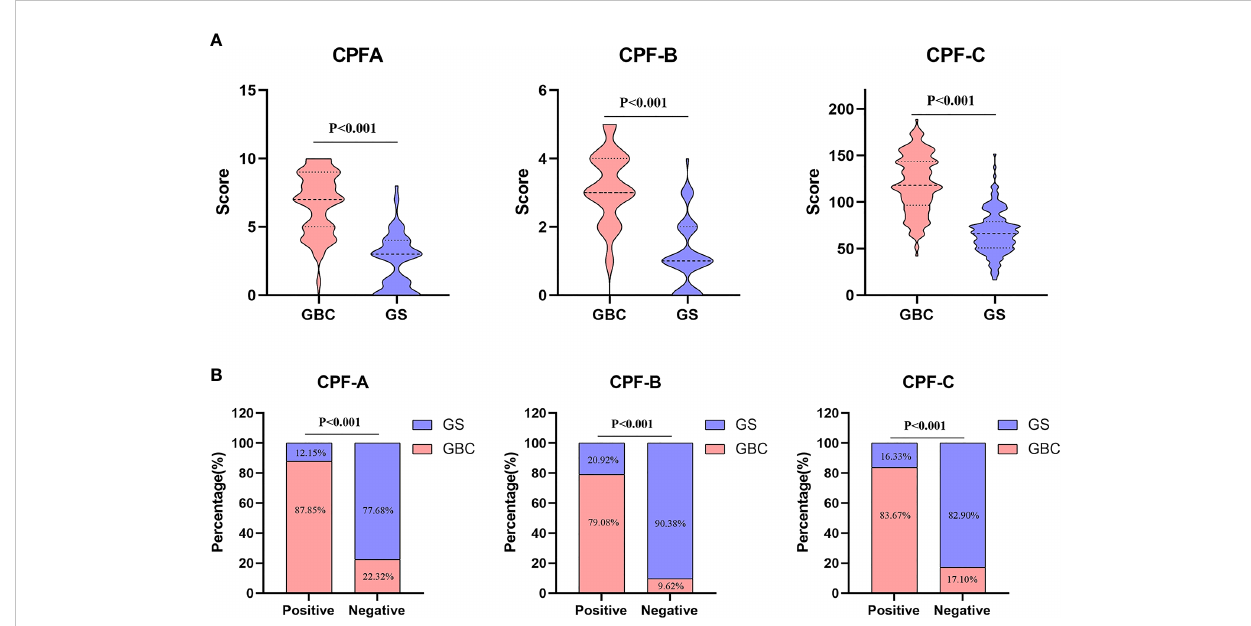
FIGURE 3 Data of combined predictive factor (CPF)-A, CPF-B, and CPF-C. (A) Comparison of CPF-A, CPF-B, and CPF-C scores between GBC and GS in the internal test samples. (B) Diagnosis rate of CPF-A, CPF-B, and CPF-C in the internal test